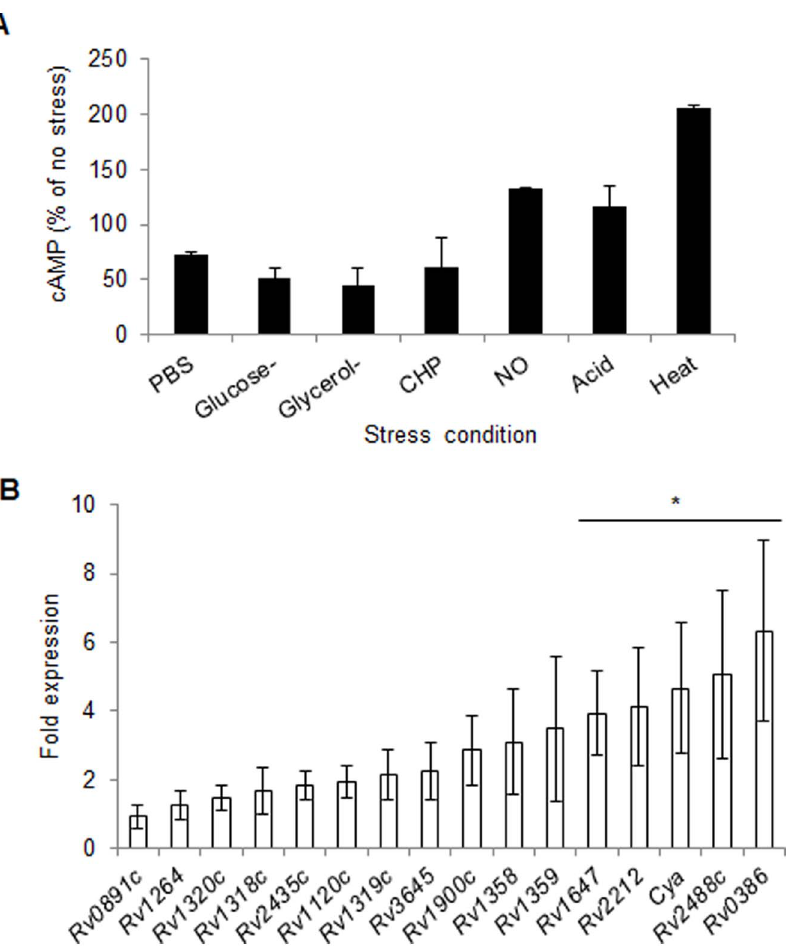
Figure 2. Effect of various stresses on intracellular cAMP levels and expression of ACs in Mtb. A) Estimation of cAMP in Mtb during in vitro growth under different stresses. Wild-type culture suspension in Middlebrook 7H9 broth at OD 600 of 0.4 was exposed to different stresses as described earlier [36] and intracellular cAMP levels were determined by ELISA. Bar graph represents cAMP level in each of the stressed samples as percentage of un-treated control. Data are the averages of three independent experiments and the mean values 6 standard deviations are shown. B) Expression analysis of the AC-encoding genes following thermal stress in Mtb. The fold-expression, as measured by qRT-PCR, indicates the ratio of sigA -normalized gene expression levels in Mtb exposed to 42 u C relative to those in the Mtb grown at 37 u C. The graph represents an average of three experiments. Error bars indicate standard deviations and asterisk denotes p # 0.05.